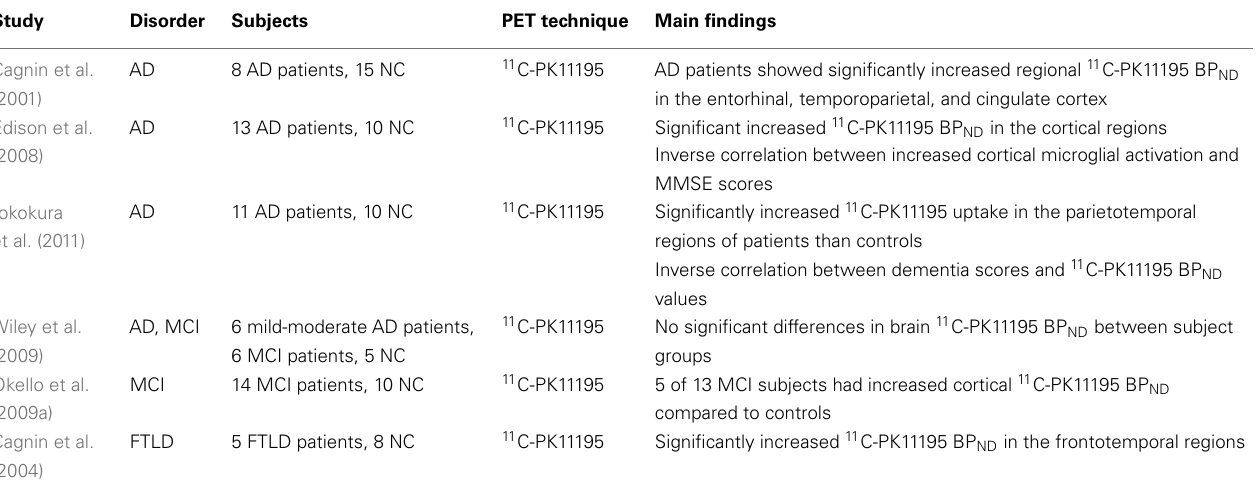
Table 3 | Positron emission tomography imaging studies assessing microglia in